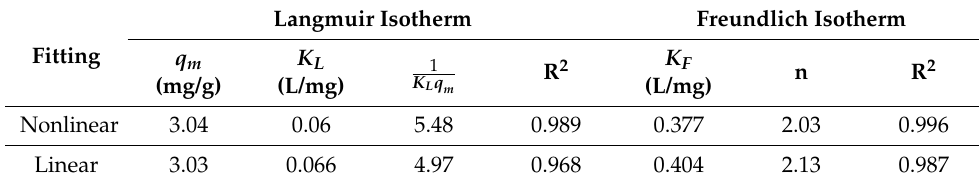
Table 4. Langmuir and Freundlich isotherm